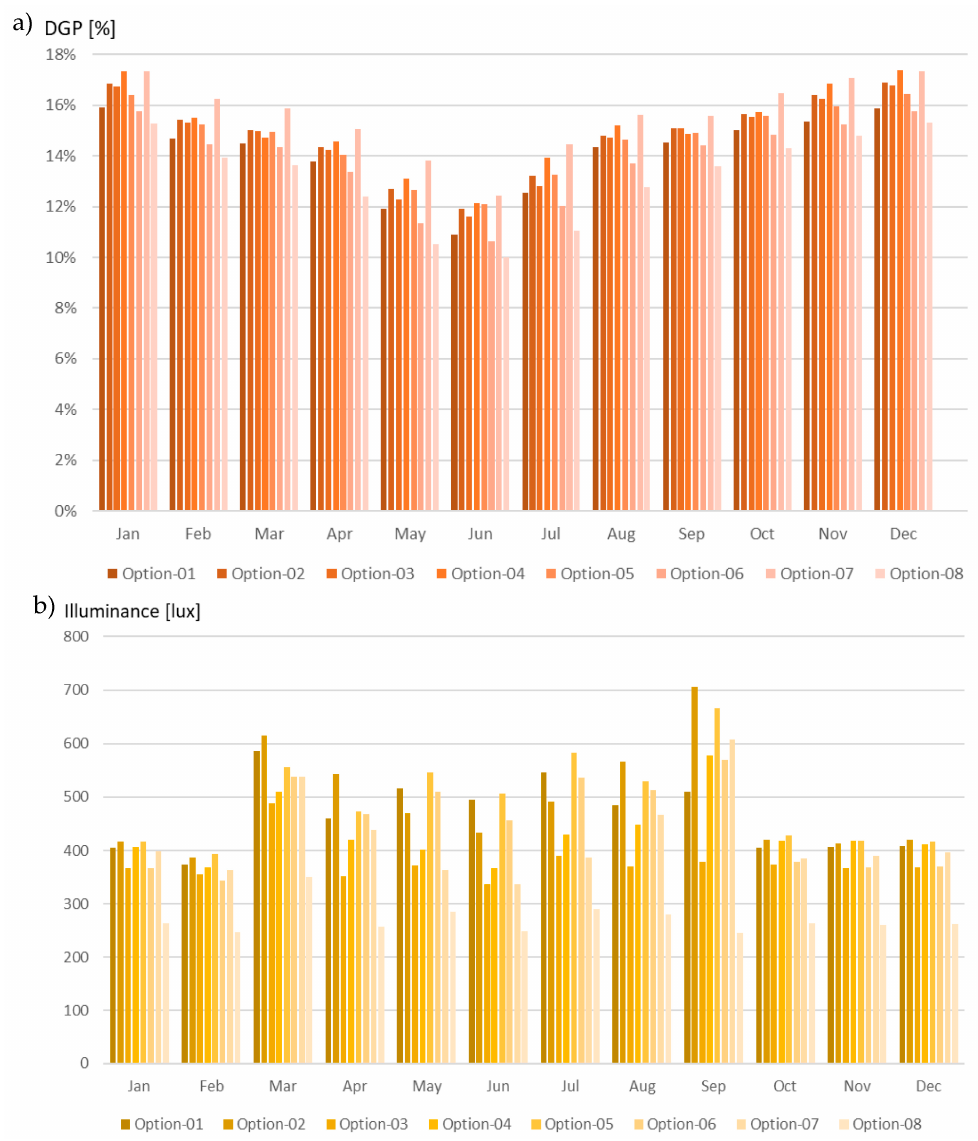
Figure 13. Monthly analysis of different options’ effect on average DGP ( a ) and mean UDI- autonomous range ( b